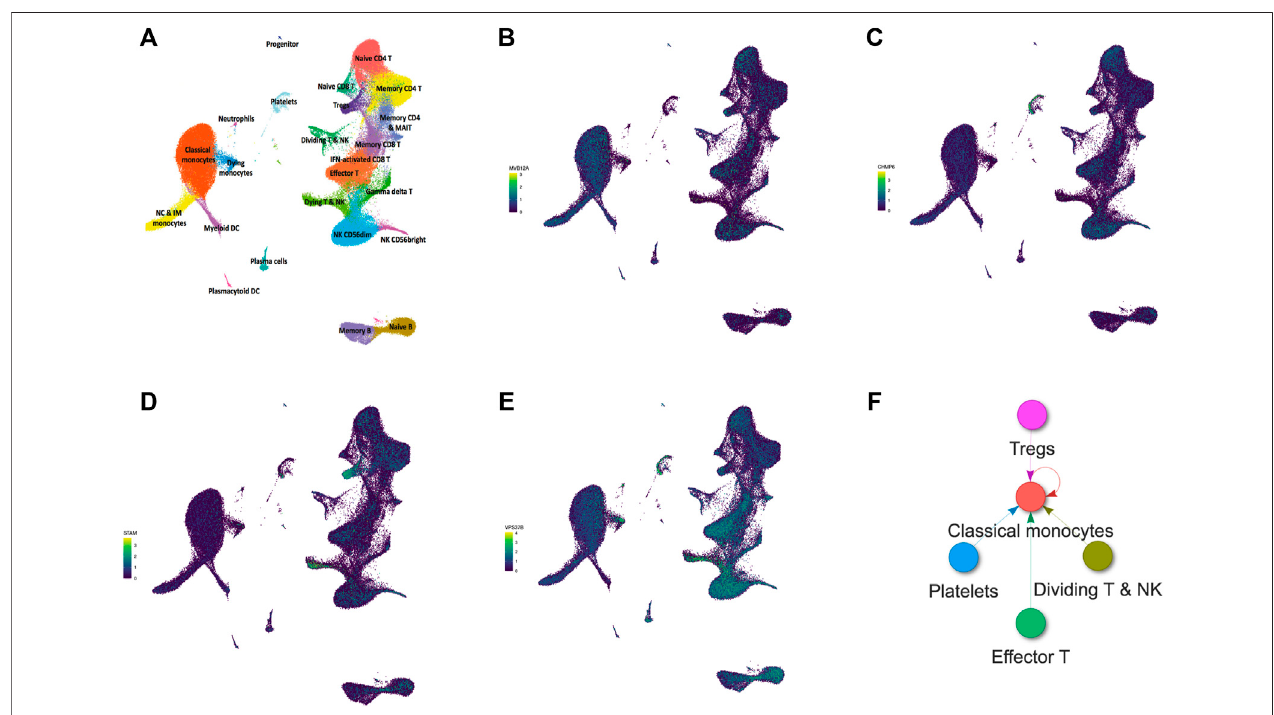
FIGURE 8 | Single-cell RNA-seq analysis of PBMCs from COVID-19 patients on an online database platform. (A) UMAP embedding of single-cell transcriptomes from 153,554 cells color-coded for the indicated cell type. (B – E) UMAP plots showing the expressions of MVB12A, CHMP6, STAM, and VPS37B in PBMCs. (F) Intercellular ligand – receptor pair interactions of PBMCs from COVID-19 progressive